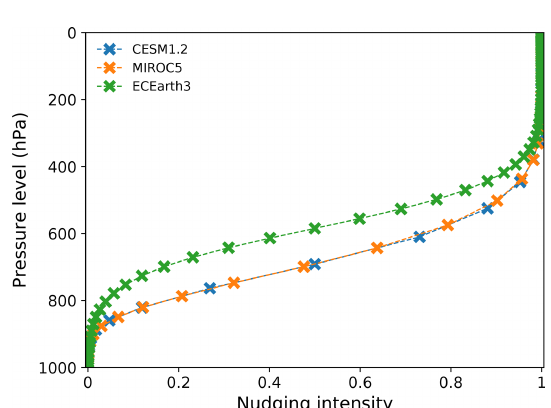
Figure B1. Nudging profile for the three ExtremeX ESMs. The ac- tual pressure levels are marked with an x and joined with lines. The nudging intensity is given from zero (no nudging) to one (fully